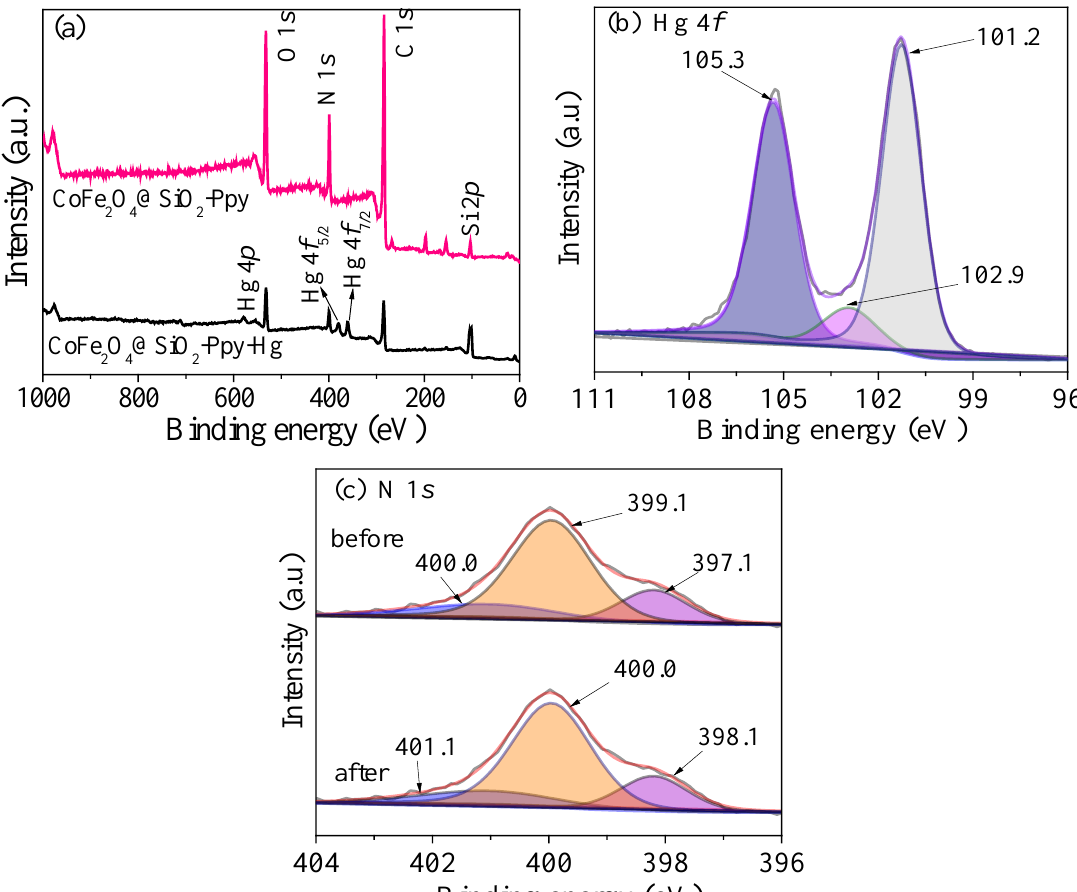
Figure 17. XPS patterns of ( a ) survey scan, ( b ) Hg 4 f and ( c ) N 1 s .